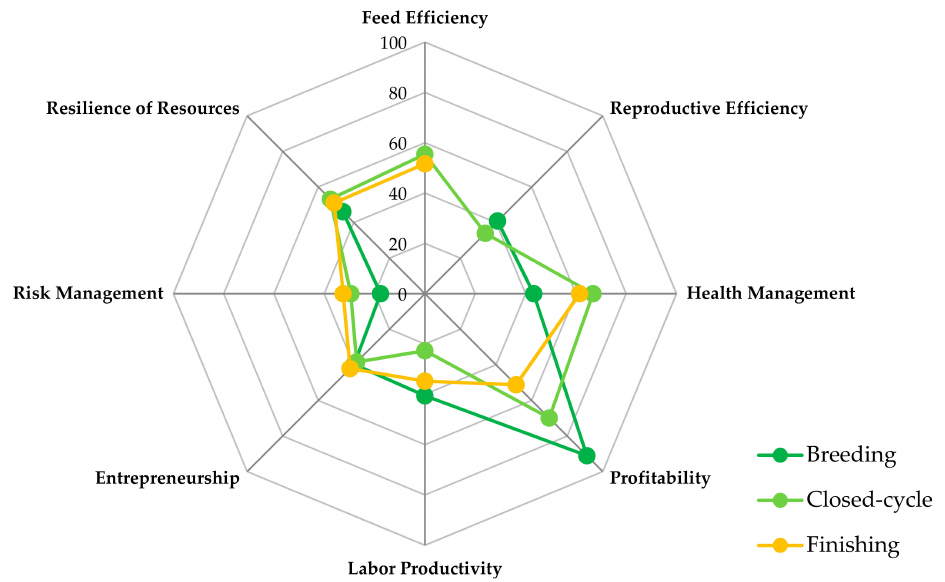
Figure 5. Spider web presenting the results of the economic sustainability assessment for different subthemes per farm